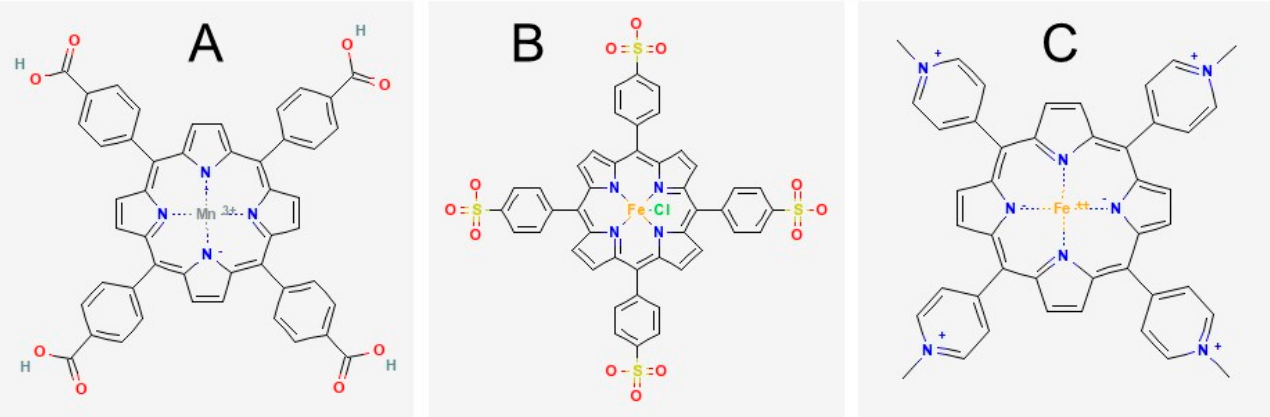
Figure 6. Metalloporphyrin structures. ( A ). structure of MnTBAP [30]. The FeTBAP structure is the same except for iron in the spot occupied by manganese. ( B ). structure of FeTPPS [31]. ( C ). structure of FeTMPyP [32]. These structure images are reused without special permission needed, according to the PubChem citation guidelines on reusing the 2D or 3D structure image of a compound or substance record.